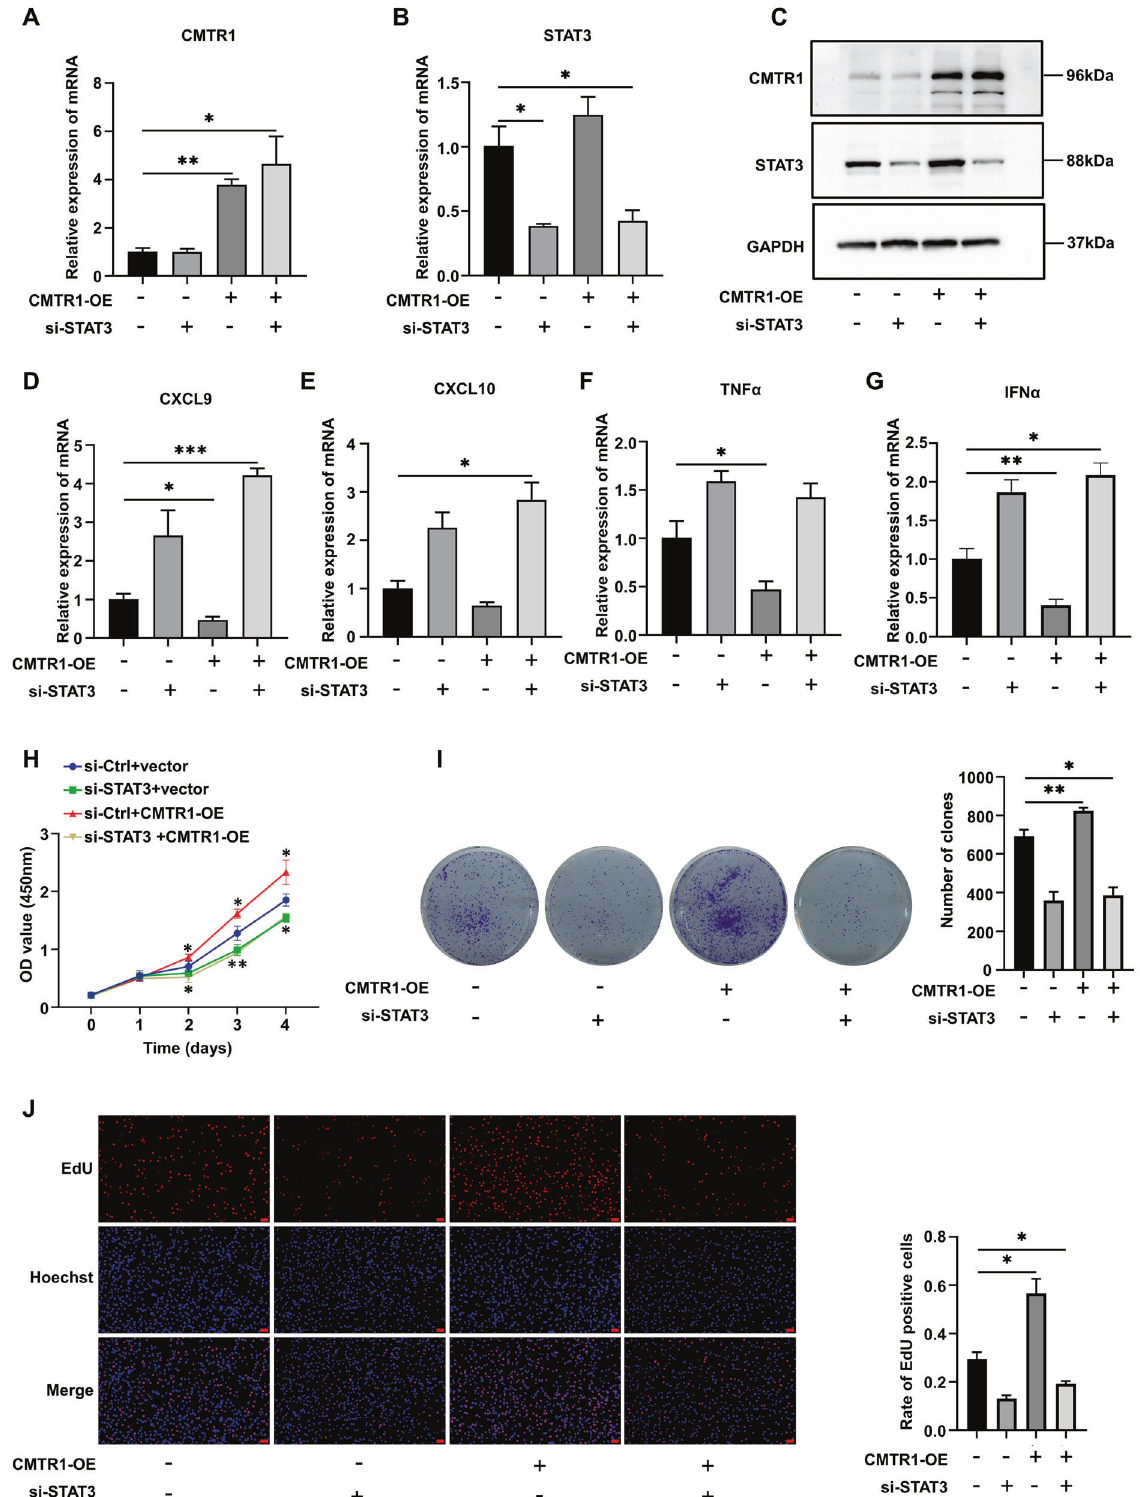
Fig. 5 CMTR1-regulated tumor cell proliferation and immune responses are STAT3-dependent. A – G Changes of STAT3 knockdown on CMTR1-induced in fl ammatory mediators. H – J Effect of STAT3 knockdown on CMTR1-induced tumor cell proliferation, as assessed by CCK8, colony formation, and EdU incorporation assays (scale bar, 50 μ m). * P < 0.05, ** P < 0.01, and *** P <